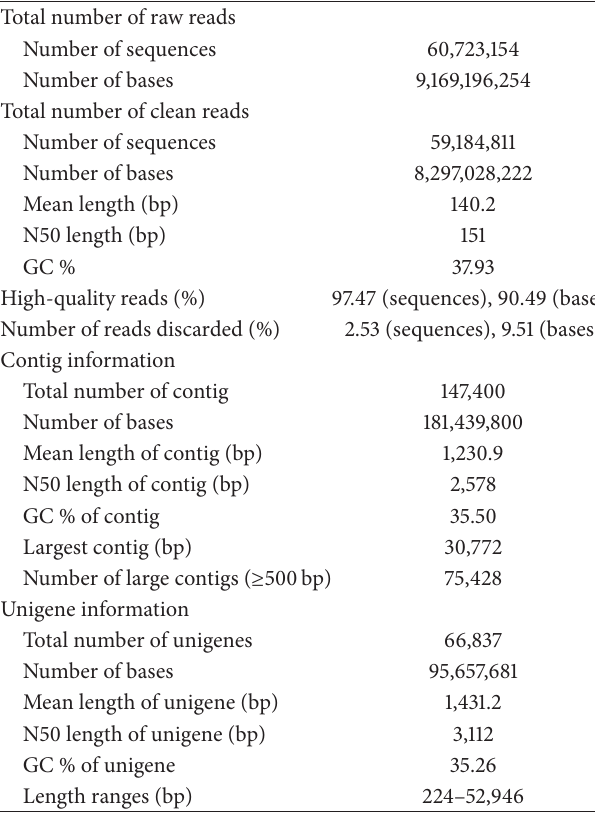
Table 1: Summary statistics of the transcription assembly for Vespa mandarinia .